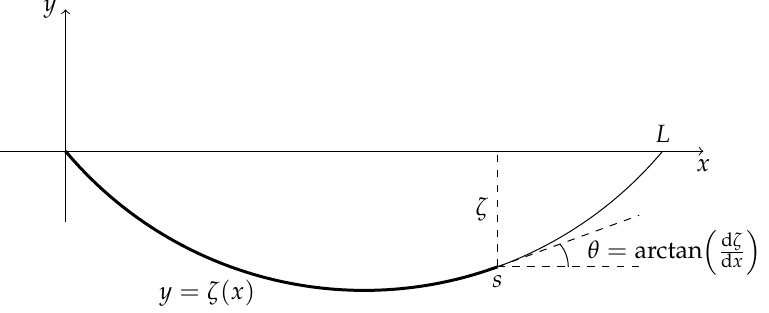
Figure 3. The Euler–Bernoulli theory of the elastica y = ζ ( x ) of beams is usually presented (i) in the linear case of a small slope, ζ (cid:48) 2 (cid:28) 1, with ζ (cid:48) ≡ d ζ /d x using Cartesian coordinates with x along and y normal to the undeflected position; (ii) in the non-linear case of an unrestricted slope, ζ (cid:48) ∼ O ( 1 ) , using curvilinear coordinates along the deflected position, namely, the arc length s and angle of deflection θ = arctan ( ζ (cid:48) ) . In the present paper, the Cartesian coordinates ( x , y ) are used as in (i), but without the restriction on slope, that is with d ζ /d x ∼ O ( 1 ) as in (ii), corresponding to the non-linear bending of an Euler–Bernoulli beam with unrestricted